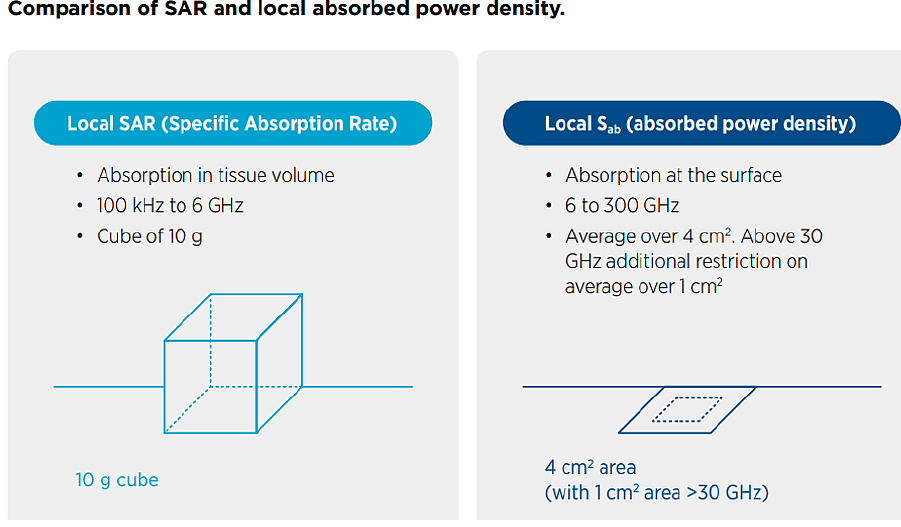
Figure 1. ICNIRP Comparison of local SAR and local absorbed power density S ab [9].